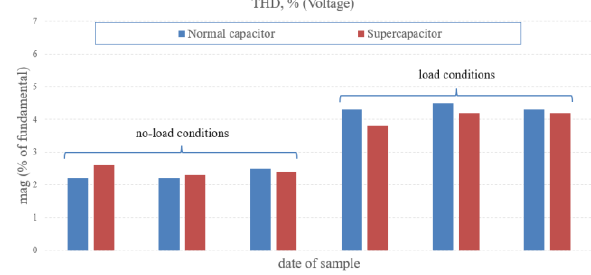
Figure 8. Influence of the converter load on the voltage THD